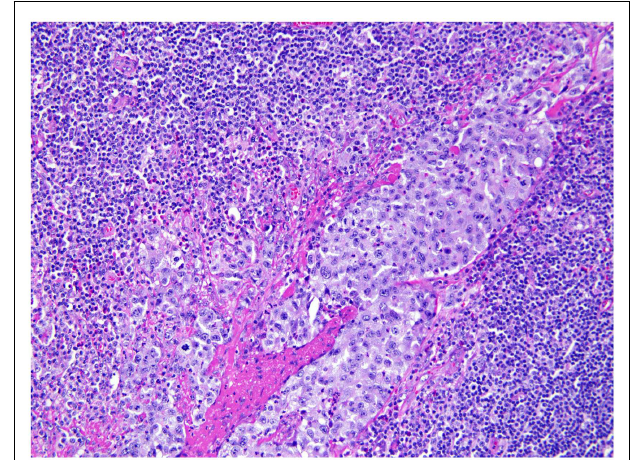
FIGURE 3 |Axillary lymph node . Axillary lymph node of the same patient shows large atypical cells involving the sinusoidal and lymphatic space, consistent with anaplastic large cells involving the lymph